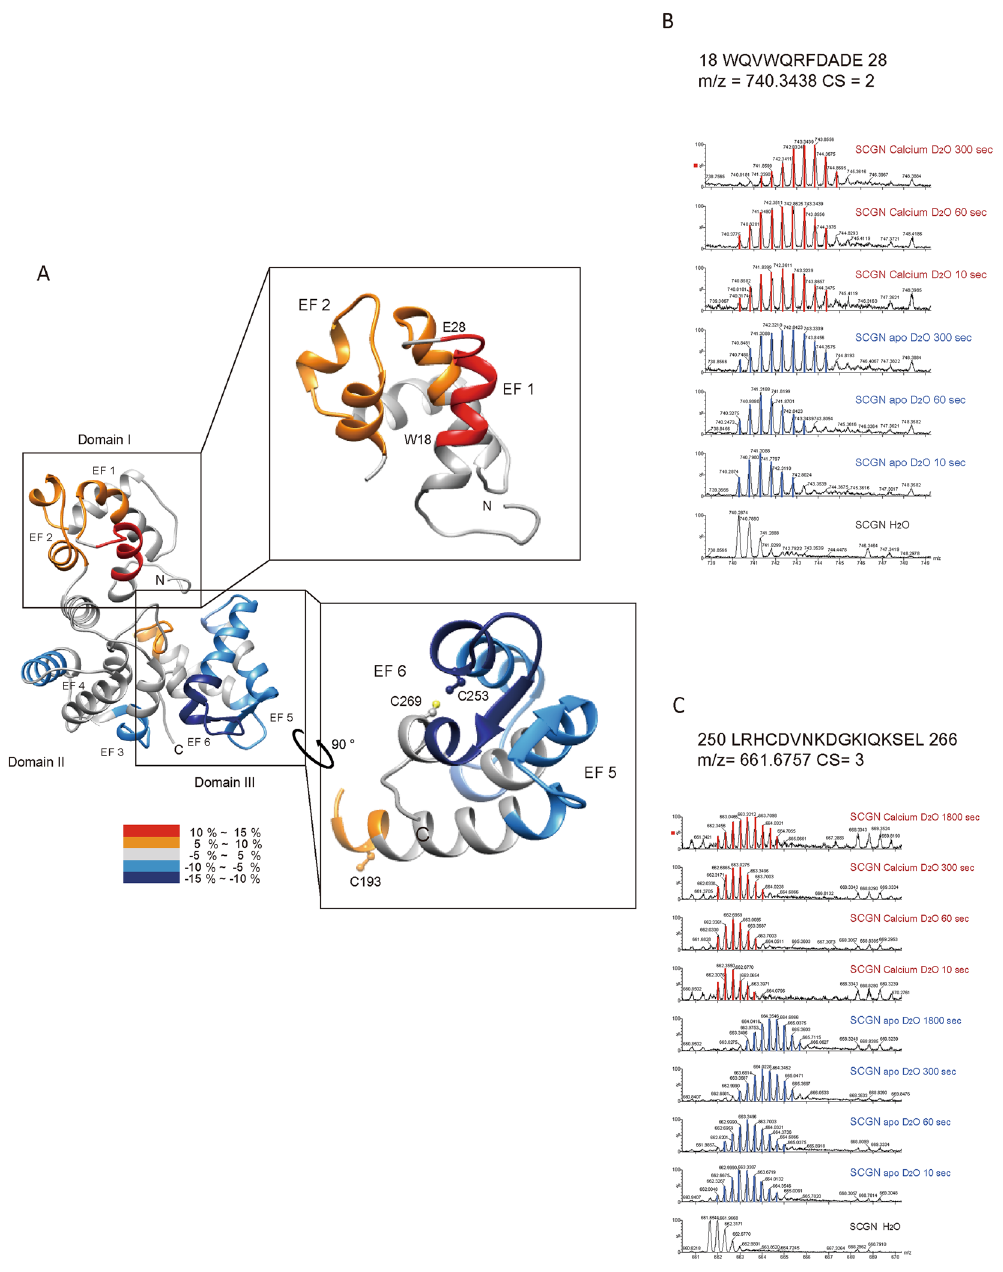
Figure 2. Structural changes in apo and Ca 2 + -bound hSCGN analyzed by hydrogen/deuterium exchange mass spectrometry. ( A ) Overlay of differential HDX data onto the structures of human SCGN structure which were modeled in silico with the MODELLER 9.9 program. Percentage difference in HDX between apo and Ca 2 + bound hSCGN is colored according to the key. The differential deuterium exchange patterns of hSCGN peptide sequences representing EF-hand and Cys residue in N-terminal ( B ) and C-terminal ( C ) peptides of